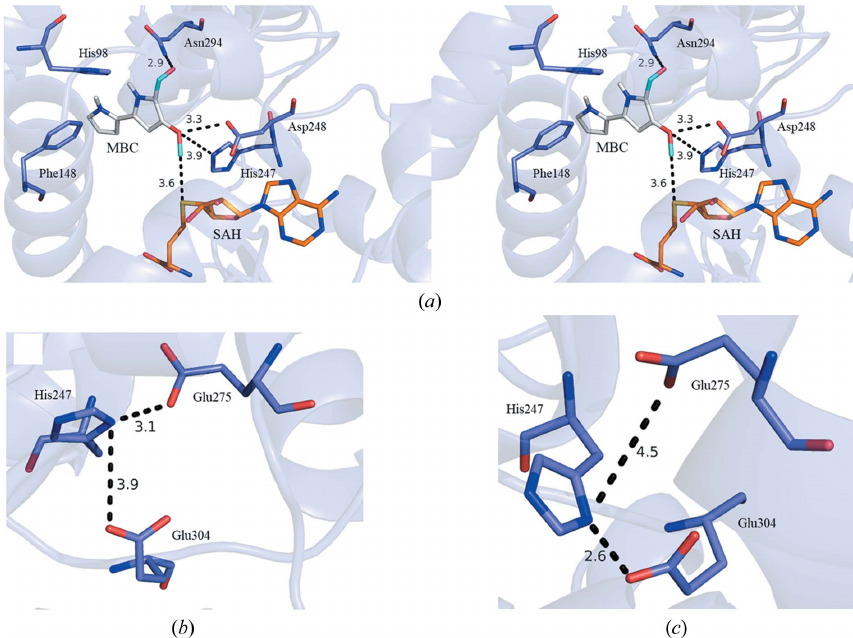
Figure 8 Docking model of PigF–SAH–MBC. ( a ) The putative substrate-binding pocket for MBC in the docking model of PigF–SAH–MBC. ( b ) The conformation of His247 in monomer A . ( c ) The conformation of His247 in monomer B . The PigF–SAH–MBC structure is shown as a blue cartoon. MBC, SAH and the residues and hydrogen bonds in PigF–SAH–MBC are coloured grey, orange, blue and black, respectively. The cartoon representation of the PigF–SAH–MBC structure is shown at 80%